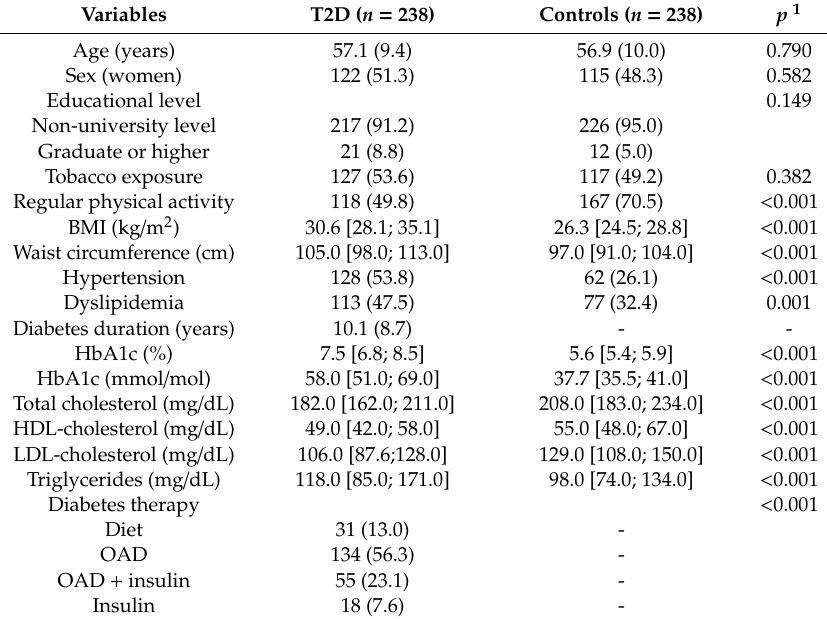
Table 1. Characteristics of the study groups.